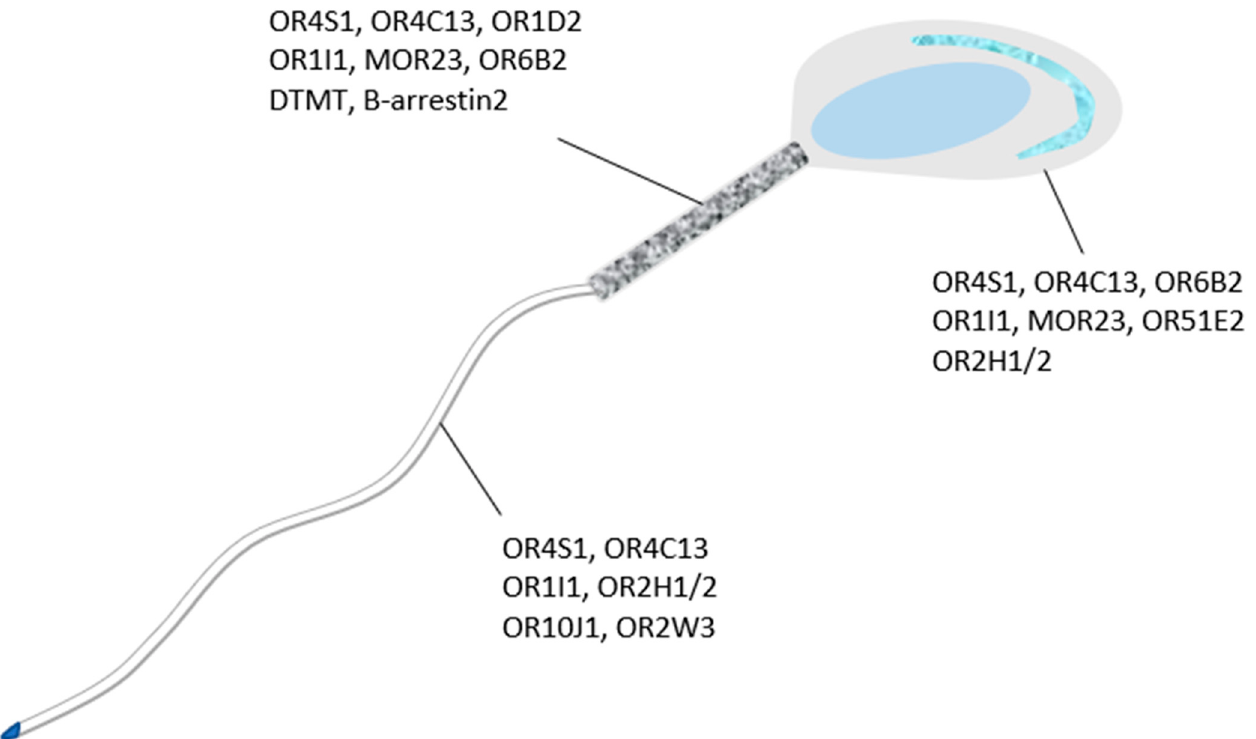
Figure 1. Different ORs/Protein localized on sperm head, mid-piece and tail. ORs in head of sperm cell are distributed at acrosomal, equatorial, and posterior head regions. Similarly, ORs of mid-piece and tail are also located along the entire lengths of these segments.